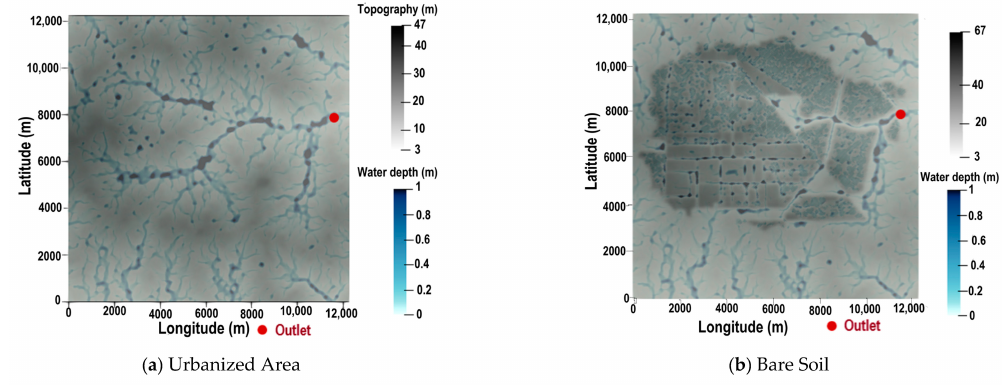
Figure 8. Flood maps after one hour of rain over the watershed for different land-use types.